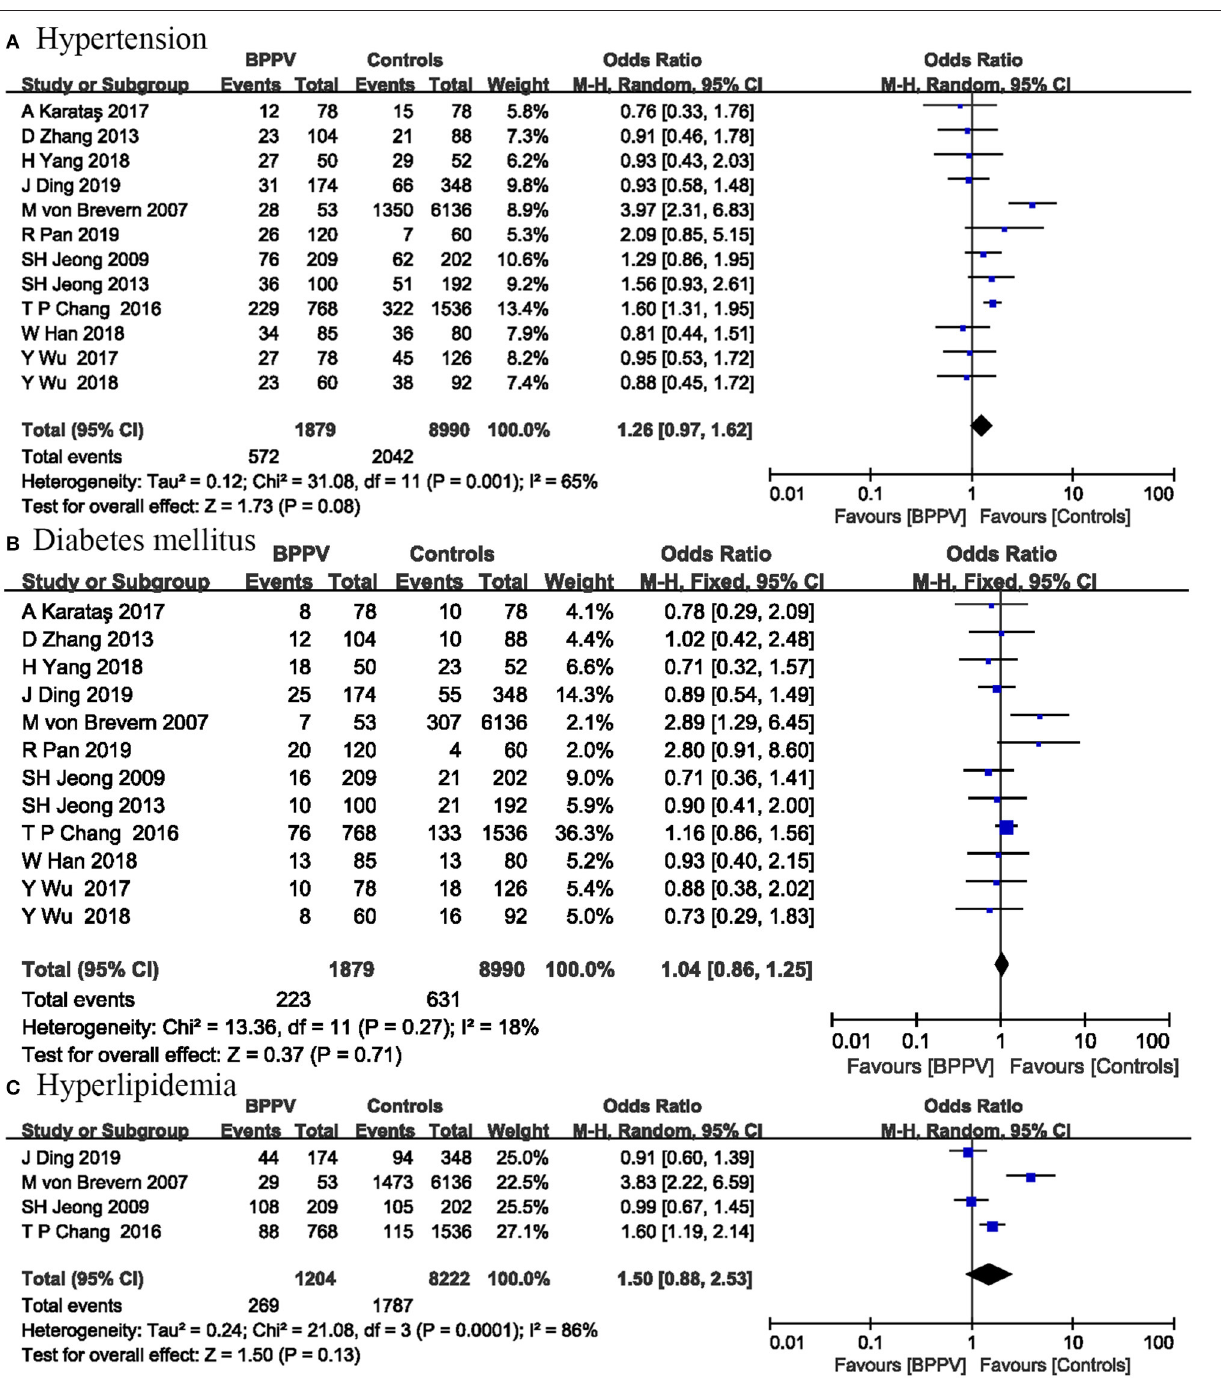
have important effects on improving the diagnosis and prognosis of patients with